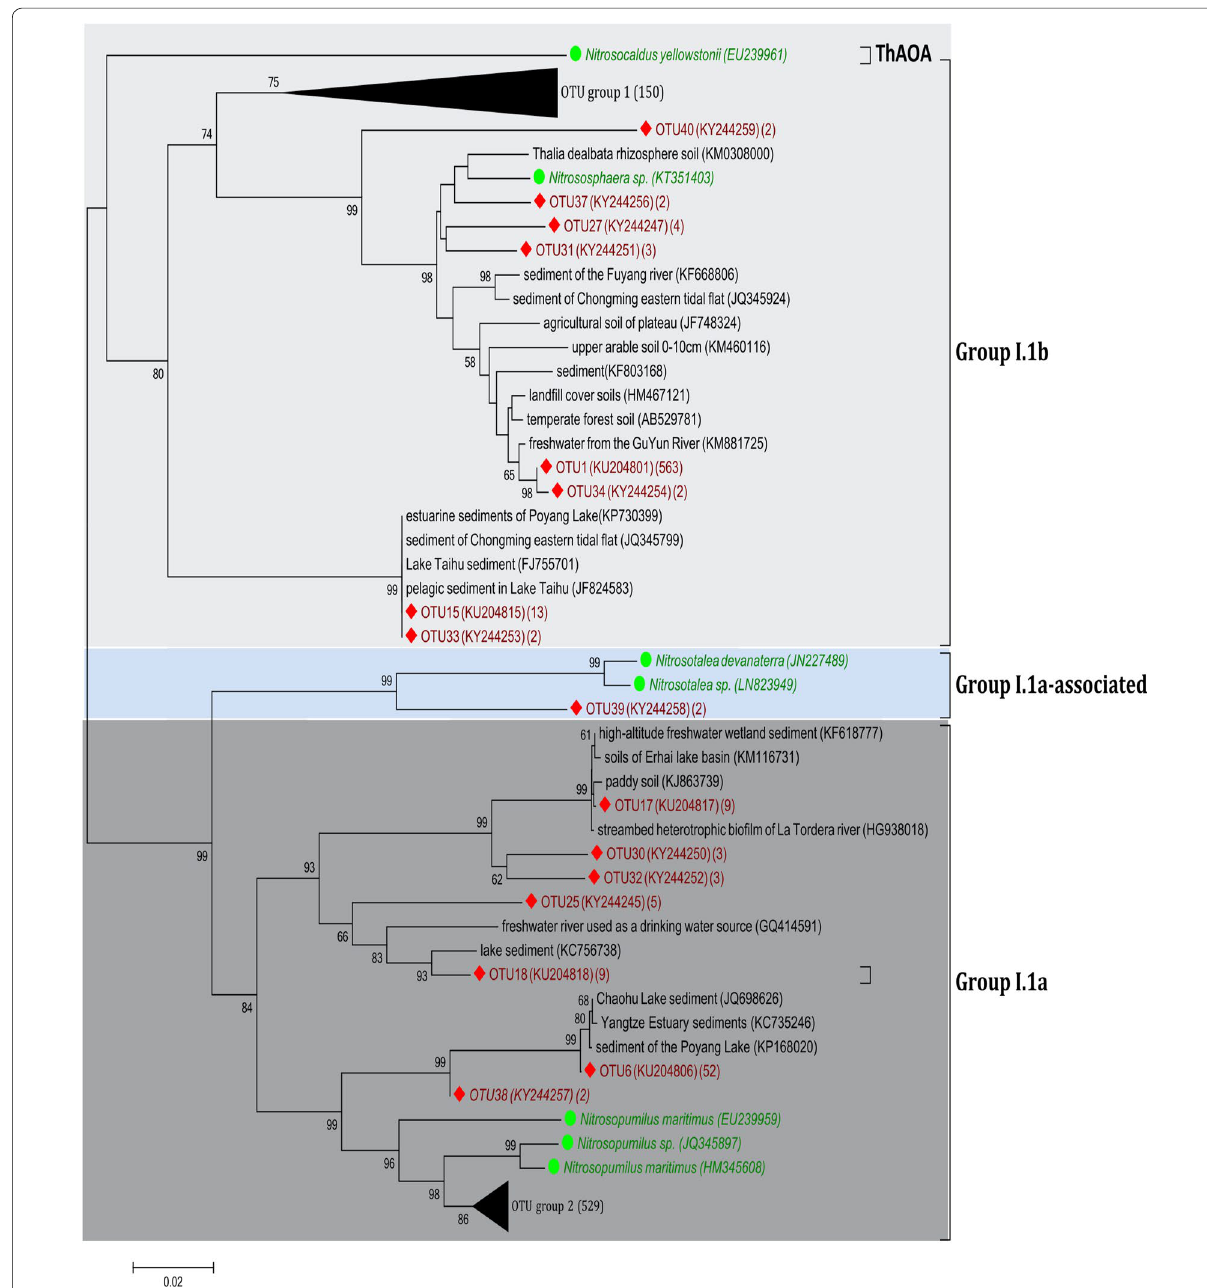
Fig. 2 Neighbor-joining phylogenetic tree of archaeal